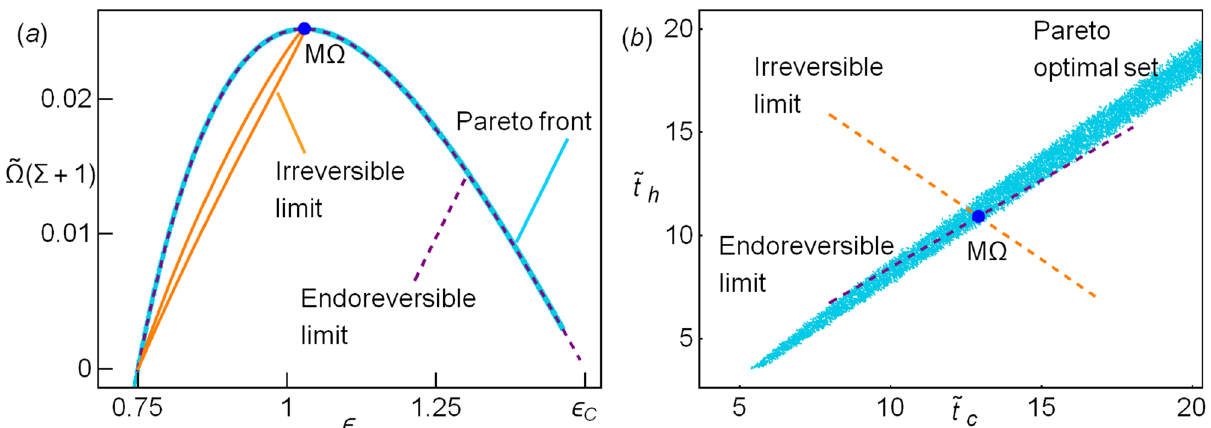
Figure 7. ( a ) The Pareto front (cyan points) matches the endoreversible limit (parabolic dashed line). The (cid:31) is the scale factor between the two normalized (cid:31) s (compare with Fig. 1a). For completeness, the term 1 + irreversible limit is also depicted (loop-like curve). ( b ) The Pareto optimal set is shown (cyan points). The irreversible limit and irreversible limits are shown. The representative values τ